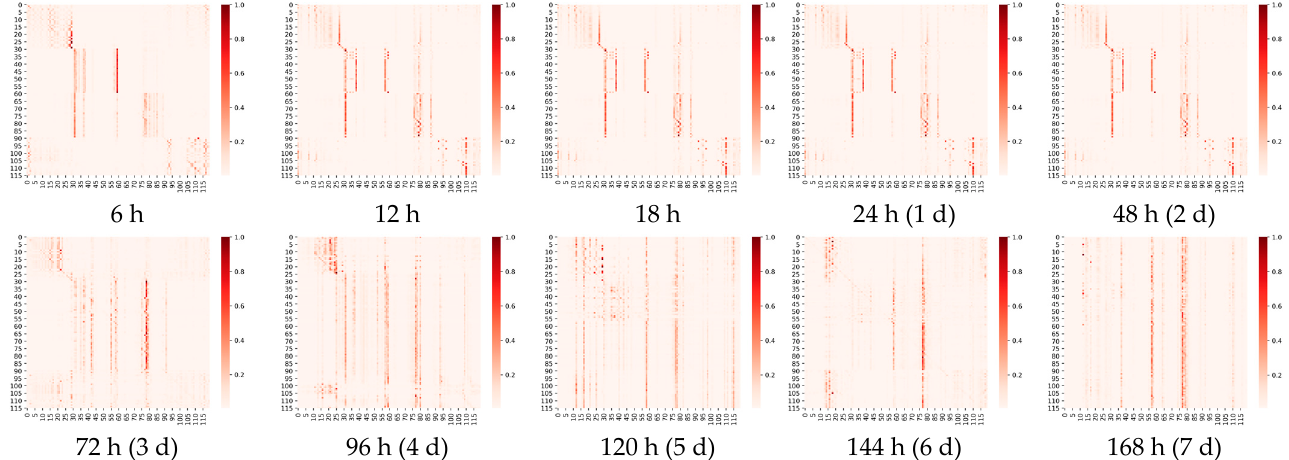
Figure A3. The learned graph structure (120 nodes) at different prediction scales, in order, 6 h, 12 h,